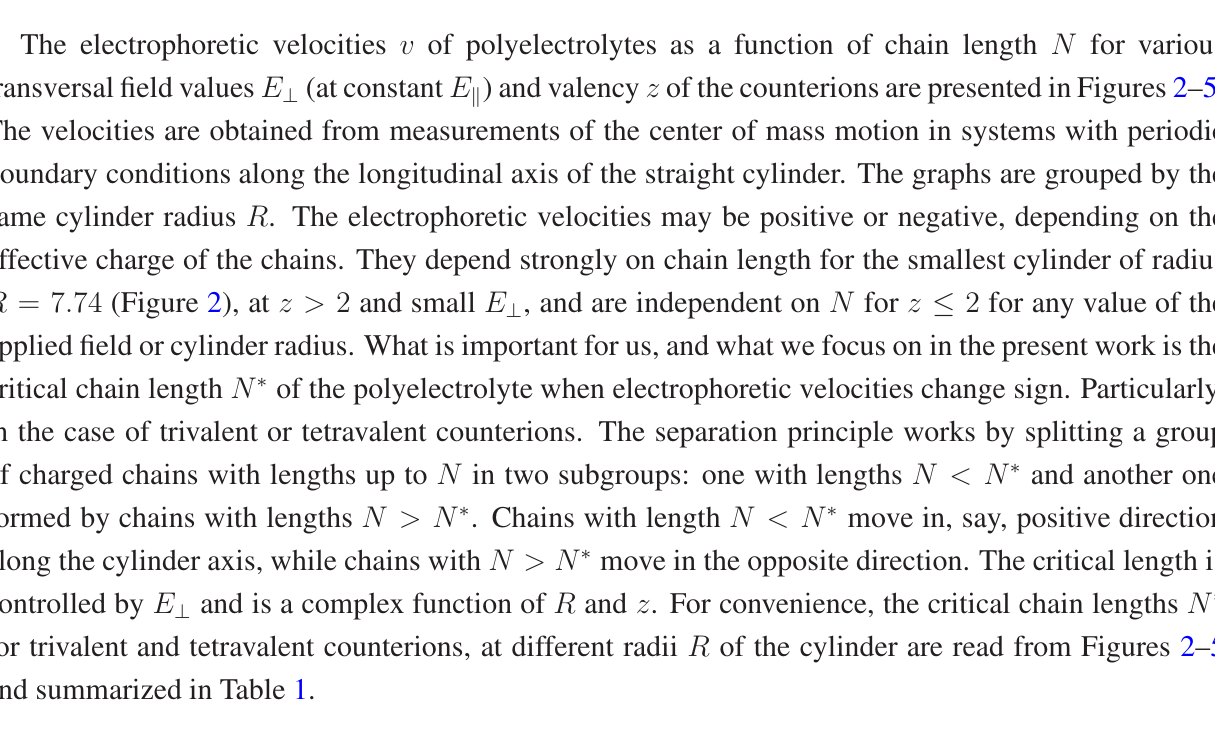
Minimum critical chain length N ∗ of the polyelectrolyte required for charge inversion, for various radii R of the cylinder, valency z of the multivalent counterions and transversal field values E . In all cases, E = 0 . 81 ⊥ k